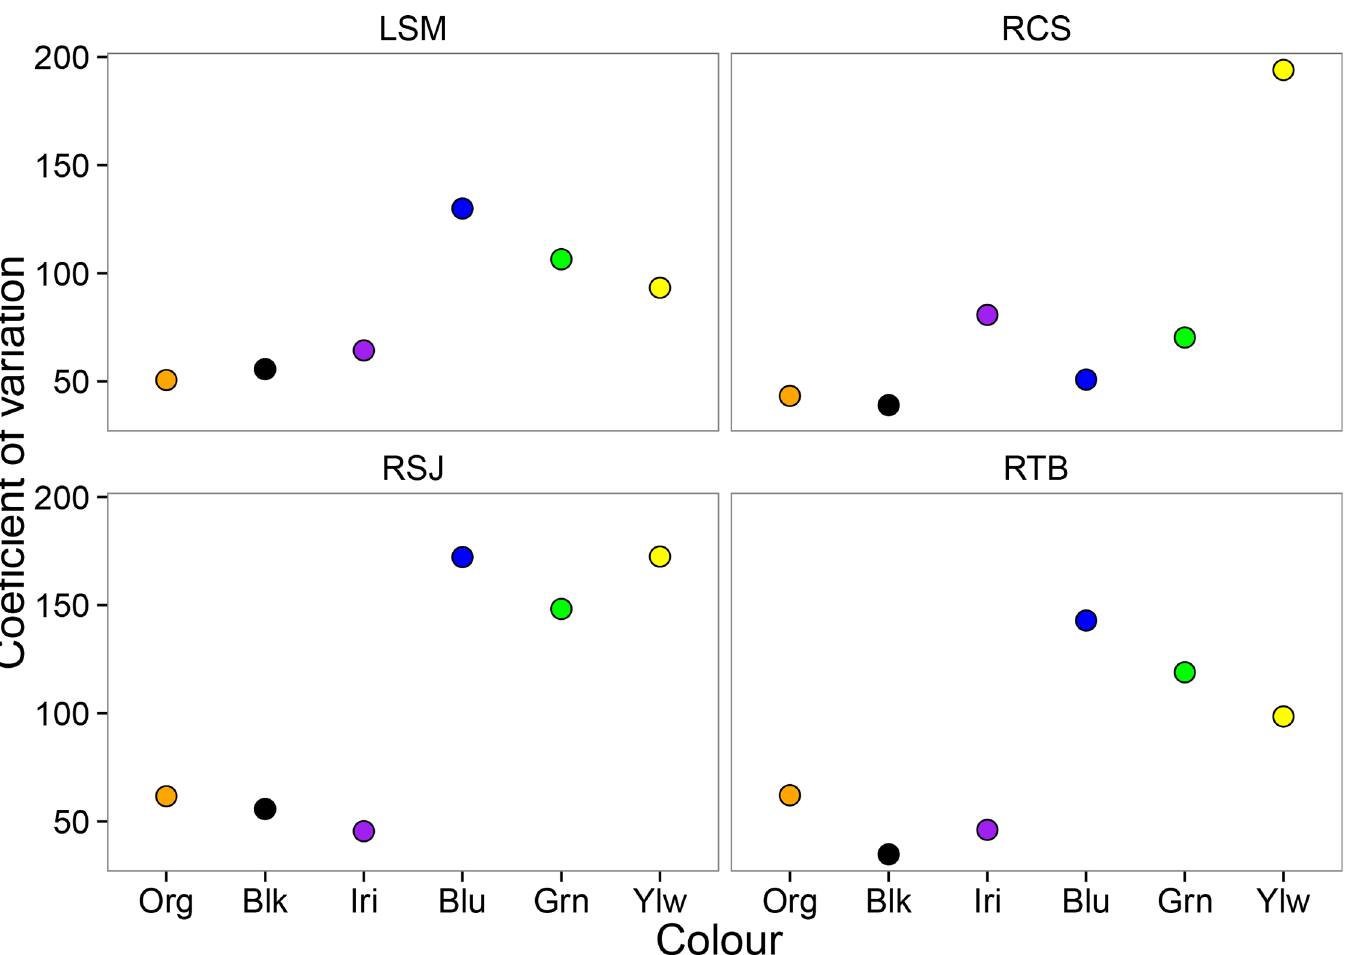
Fig 3. Variability in colour patterns in introduced populations of P . reticulata in Panama. Variability is given by the coefficient of variation (CV) across sites. Colour conventions are the same as in Fig